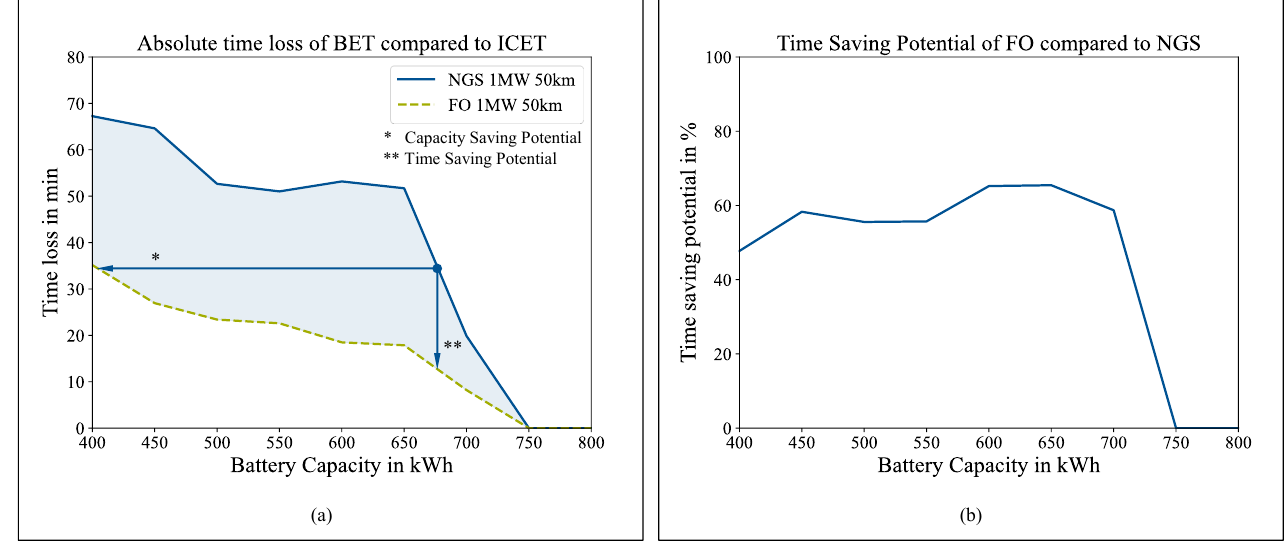
Figure 5. ( a ) Absolute time loss when operating with BET using the NGS and FO strategy compared to the operation with ICET. The area between both curves can be interpreted as the time- and capacity-saving potential. ( b ) Relative time-saving potential of the FO strategy compared to the NGS strategy.